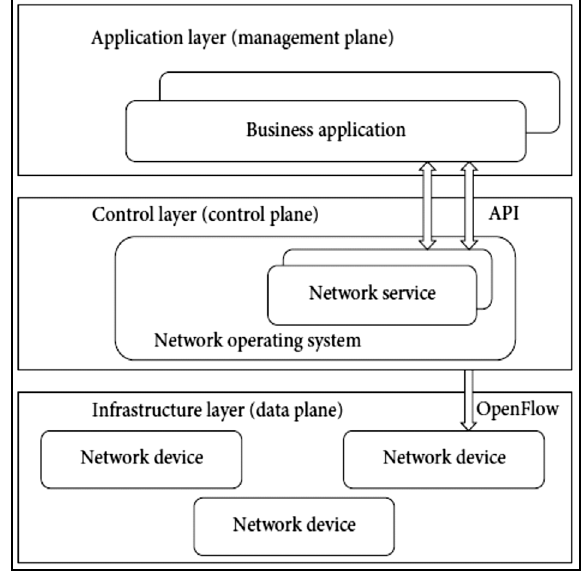
Figure 1. The Eventual Structural design of